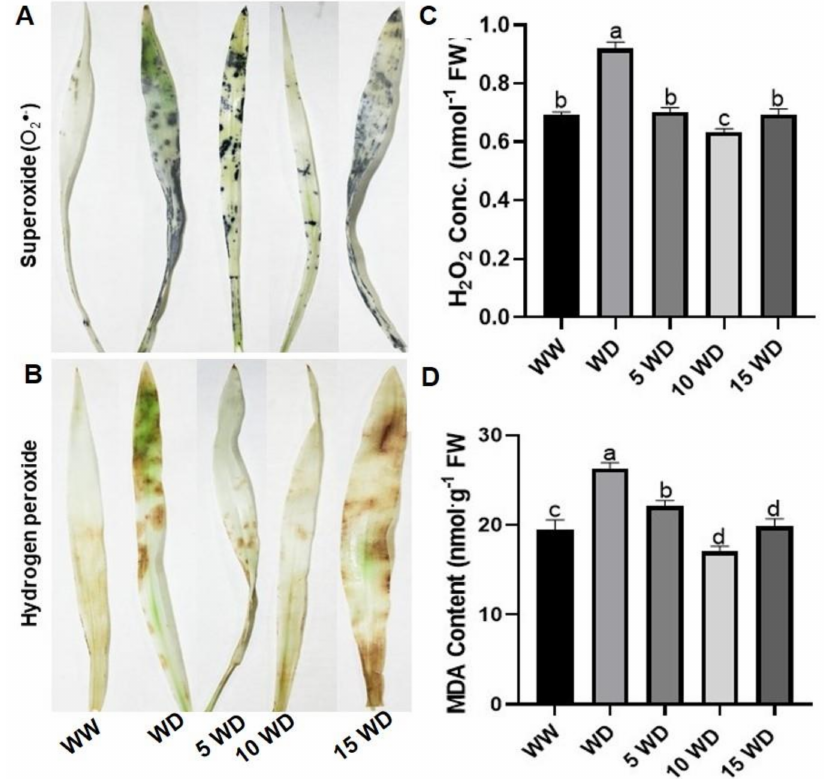
Figure 6. Effect of drought and α Fe 2 O 3 NP priming on oxidative stress markers: Histochemical detec- tion of O 2 •− ( A ) and H 2 O 2 ( B ); Quantification of H 2 O 2 ( C ) and MDA content ( D ) in sorghum plants. WW = well-watered (control); WD = water-deprived (drought stress); 5 WD = water- deprived + 5 mg/L α Fe 2 O 3 NPs; 10 WD = water-deprived + 10 mg/L α Fe 2 O 3 NPs, and 15 WD = water-deprived + 15 mg/L α Fe 2 O 3 NPs. Data in the figure represent the mean ± stan- dard deviation ( n = 3). Different letters indicate significant differences ( p < 0.05) based on ANOVA one-way variance analysis using Tukey’s comparison